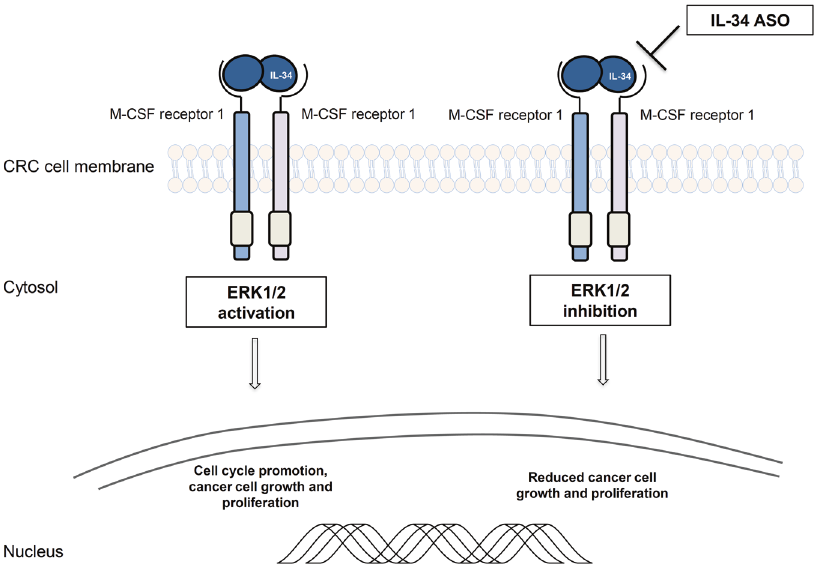
Fig. 2 Schematic view of IL-34 as a regulator of CRC cells proliferation. IL-34 knockdown in CRC cells with an antisense oligonucleotide inhibits ERK1/2 thereby reducing cell proliferation. CRC colorectal cancer, ASO antisense